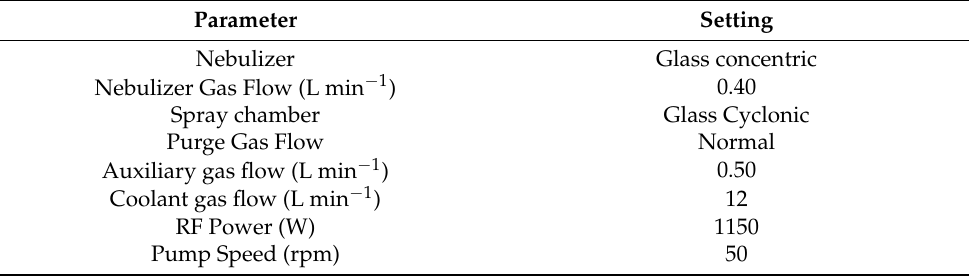
Table 3. Operating conditions and acquisition parameters for